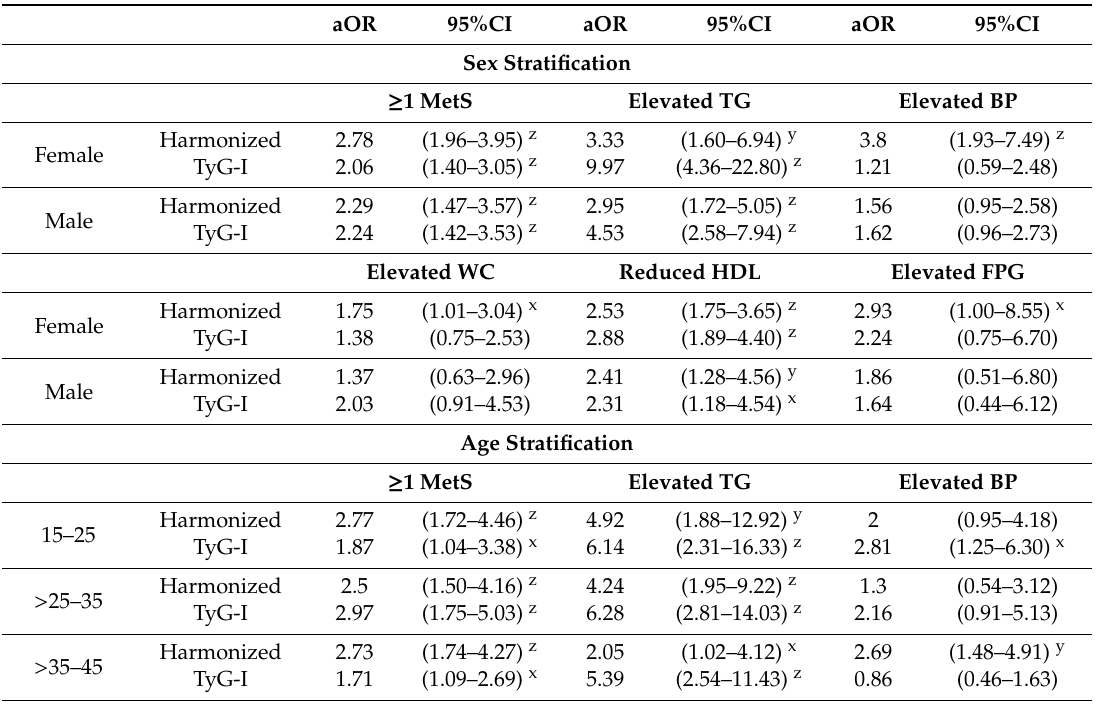
Table A1. OR for outcome of having components, according to the Harmonized Criteria and the TyG index, in normoweight young adults (with healthy individuals as the reference in each